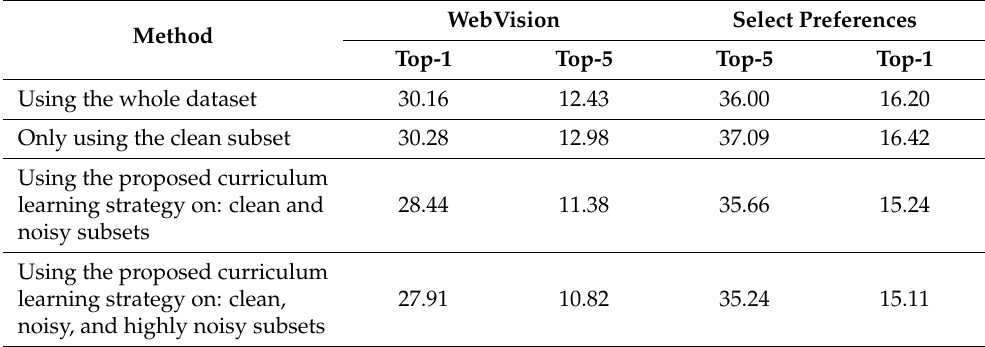
Table 6. The experiments on the curriculum learning model (modified table from